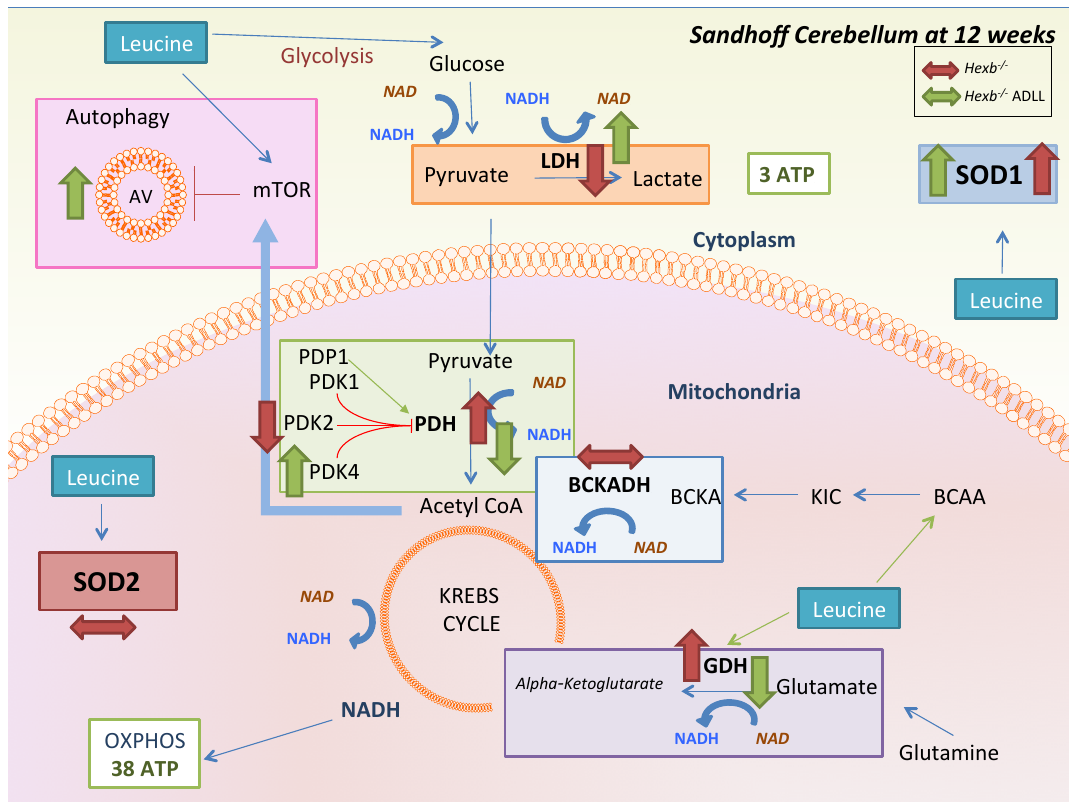
Figure S1: Total GSL levels at 12 weeks in Hexb - / - mice with and without treatment. Wild-type untreated ( Hexb +/+ ), Sandho ff untreated ( Hexb - / - UT), ADLL treated ( Hexb - / - ADLL). Hexb +/+ (n = 2), five animals for Hexb - / - UT and Hexb - / - ADLL, mean ± SD (two-way